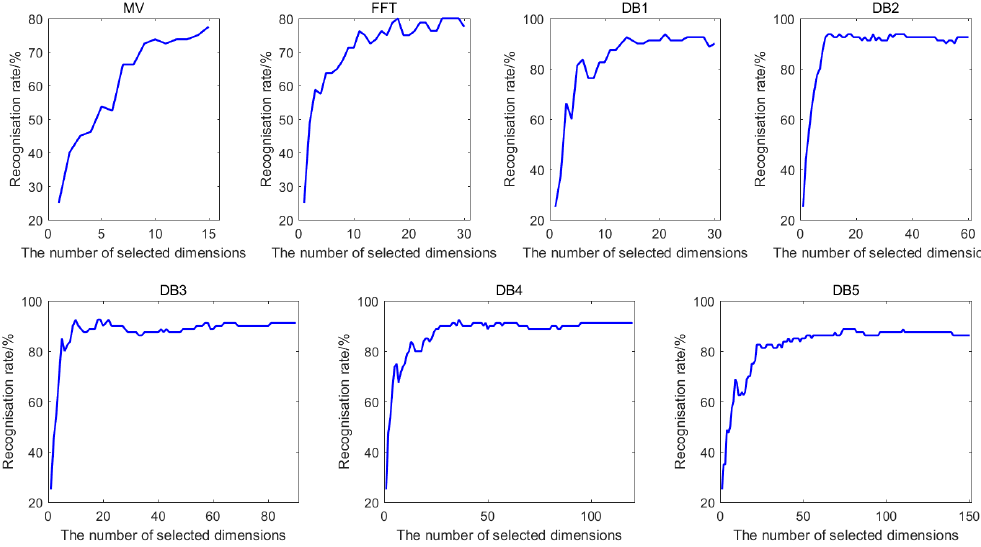
Figure 4. The classification accuracies of seven features for Dataset I.